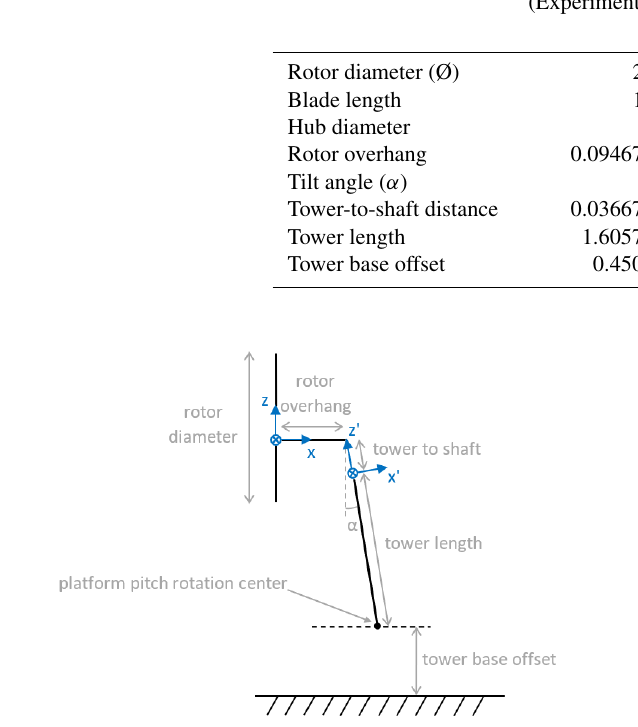
Figure 2. Schematic representation of the wind turbine system and the coordinate systems (hub fix and tower